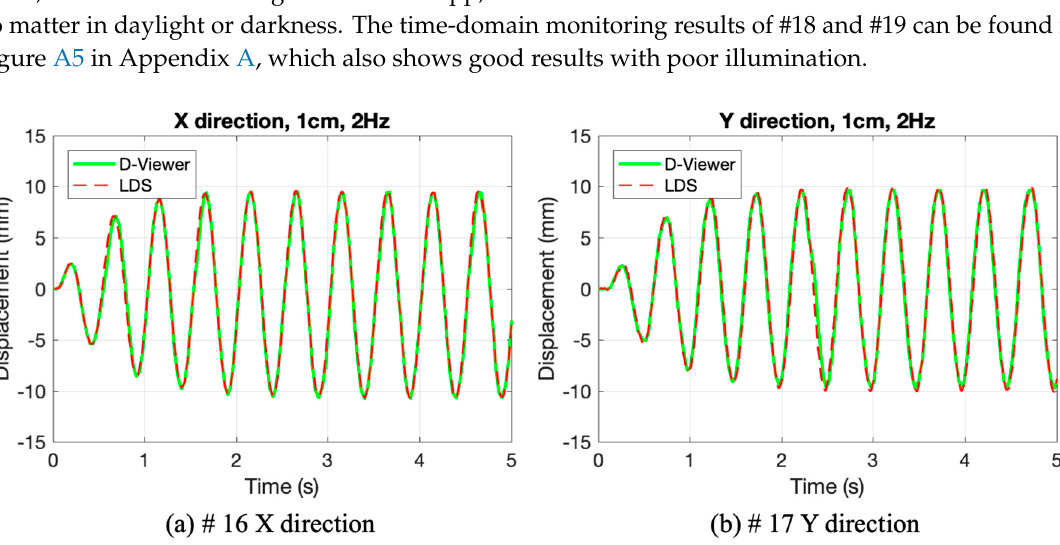
Figure 8. The results of the experiments #16 and #17: ( a ) #16 X direction; ( b ) #17 Y direction.